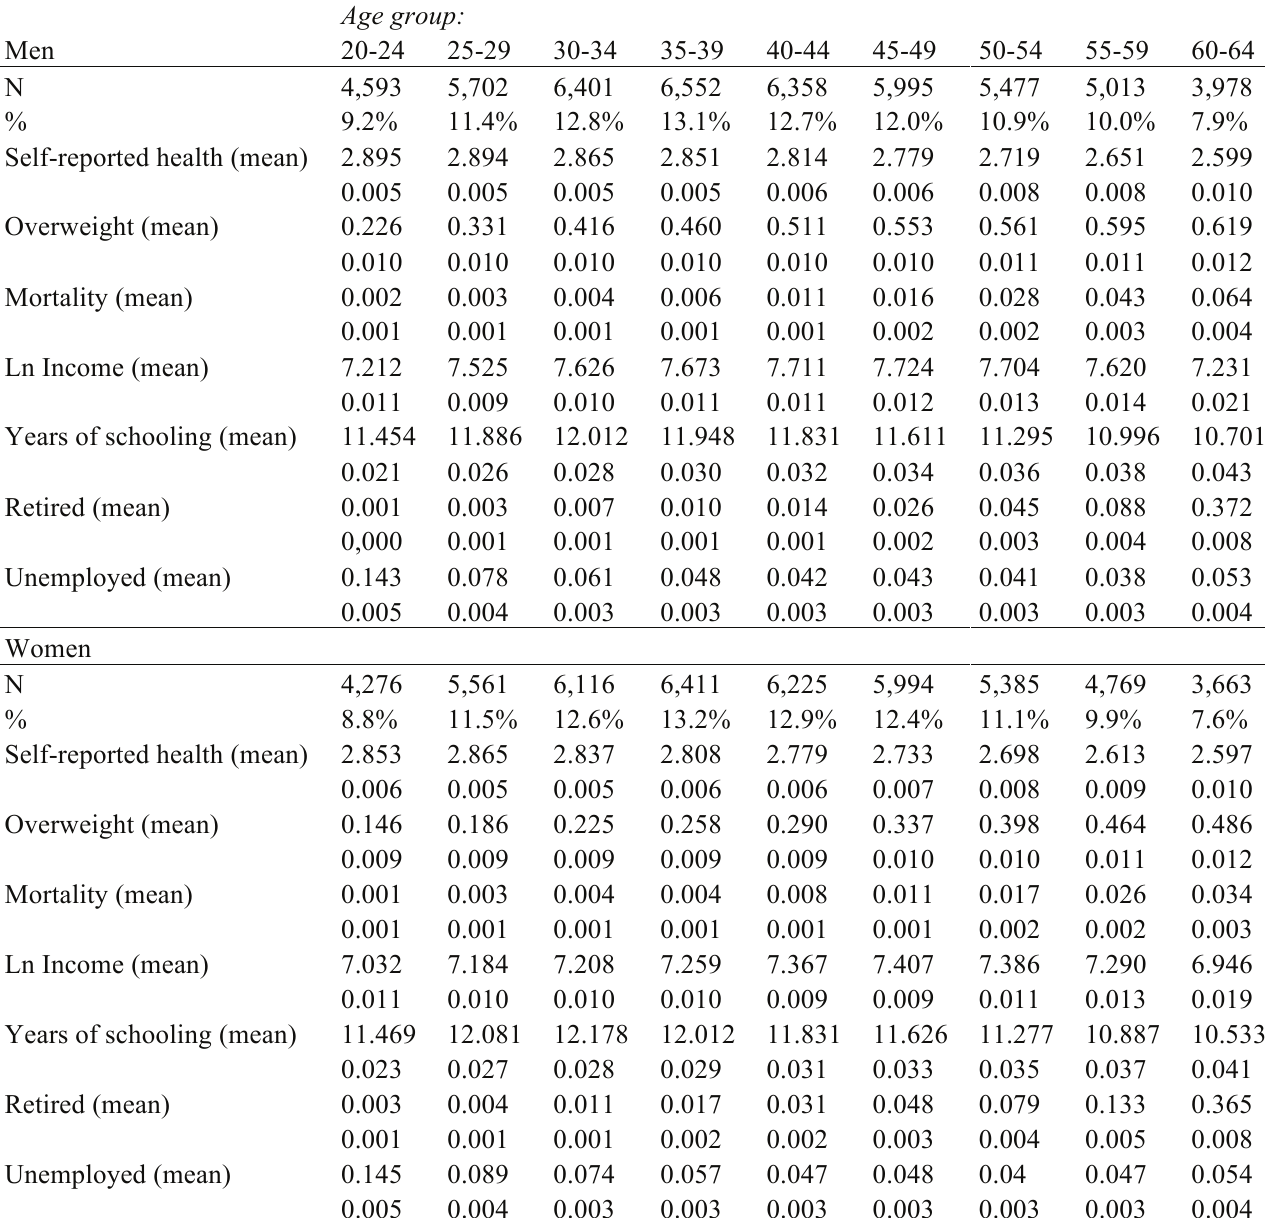
Table 1. Descriptive statistics. Observations, means and standard deviations for the age groups. Age